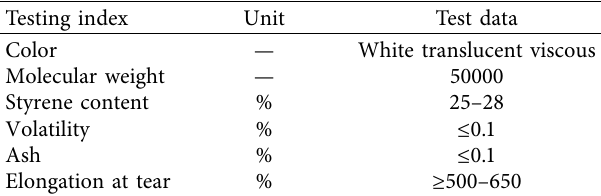
Table 2: Basic properties of liquid